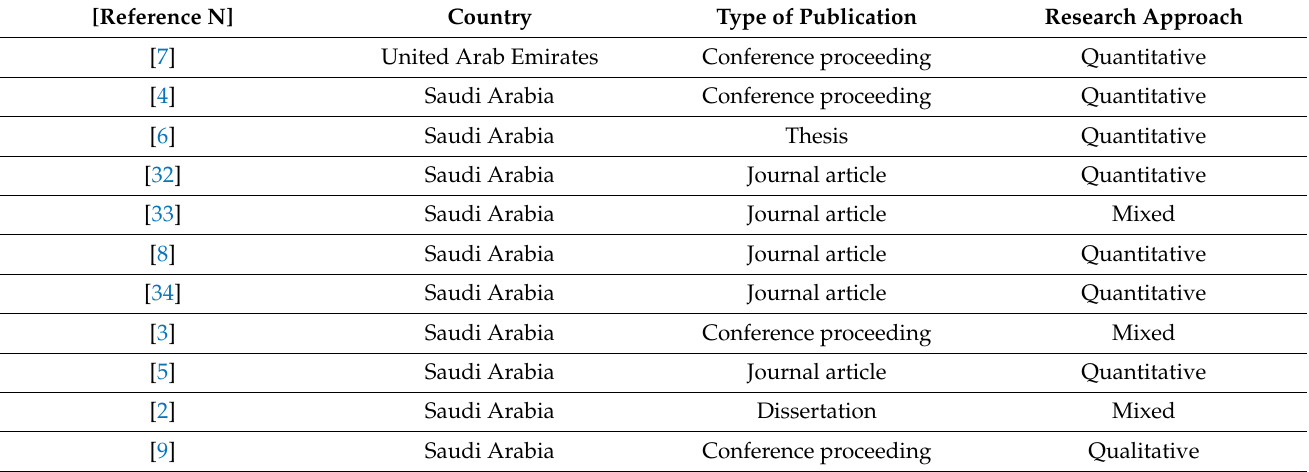
Table 2. Characteristics of included studies.